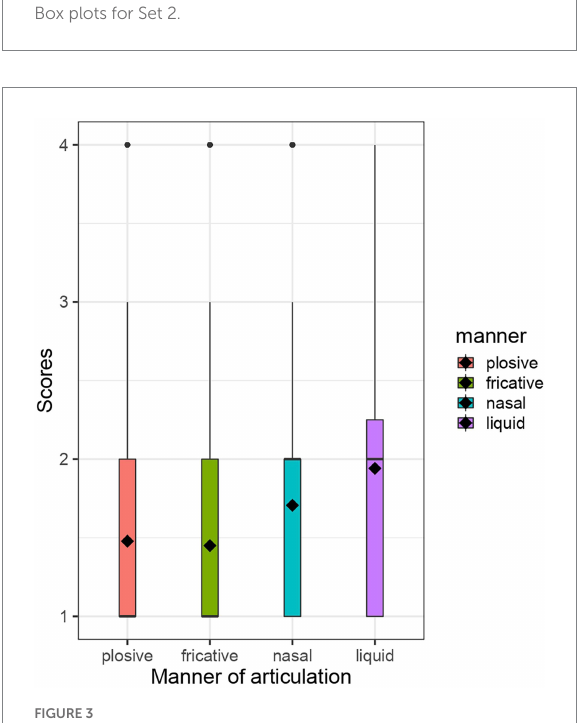
FIGURE 3 Box plots for Set